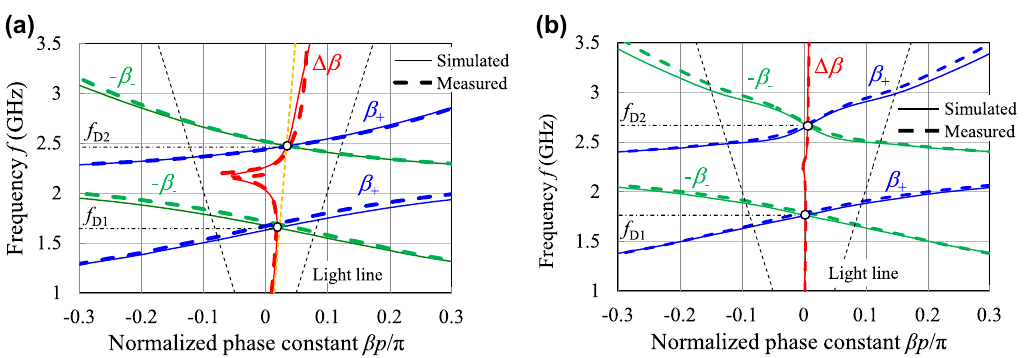
Figure 5: Dispersion diagrams and the phase-shifting nonreciprocities that are extracted from the transmission coefficients for the designed and fabricated dual-band CRLH metamaterial lines. (a) Nonreciprocal cases with the internal dc field μ 0 H 0 = 140 mT in the numerical simulation, and the externally applied dc magnetic fi eld μ 0 H ext = 300 mT in the measurement. (b) Almost reciprocal cases with measurement.